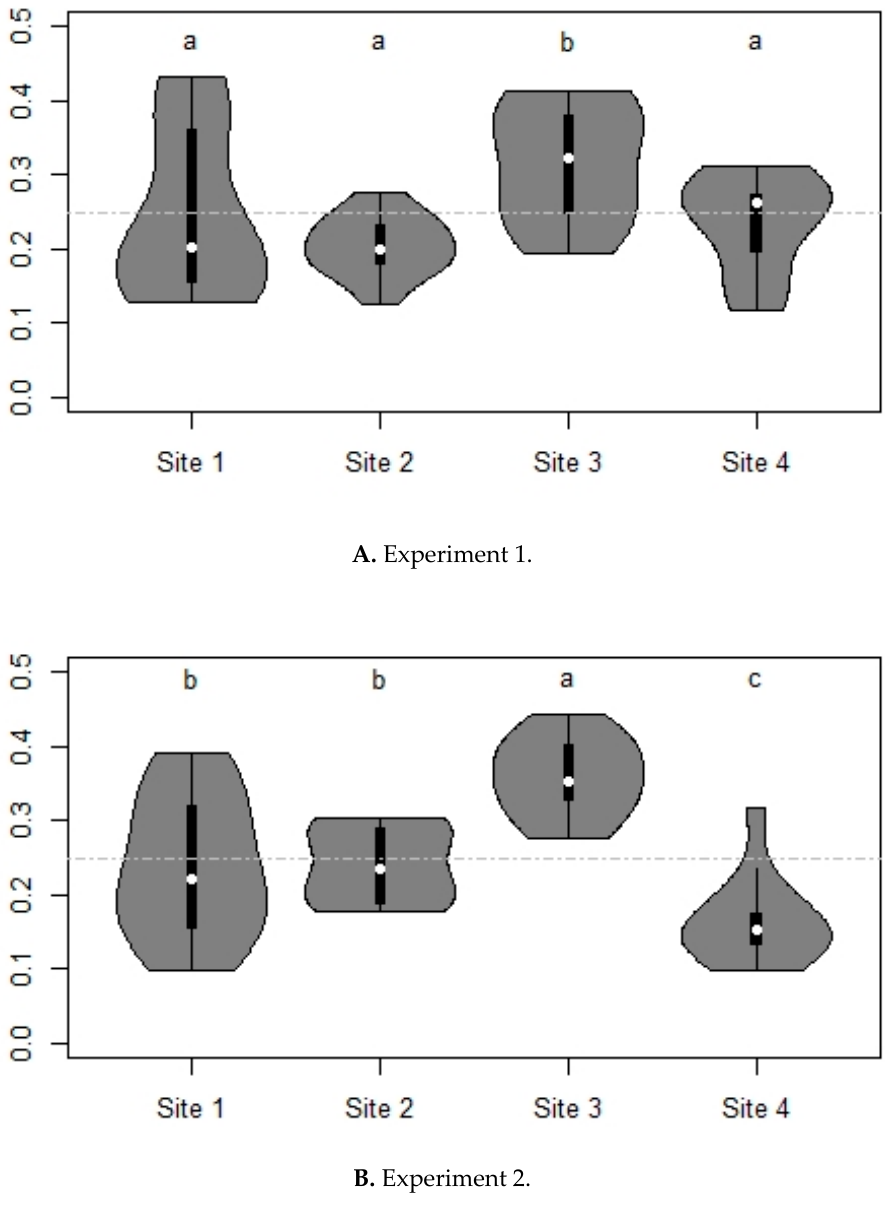
Figure 5. Proportion of stable flies captured by location in experiment 1 ( A ) and in experiment 2 ( B ). See Figure 3 for explanations about the violin plots.